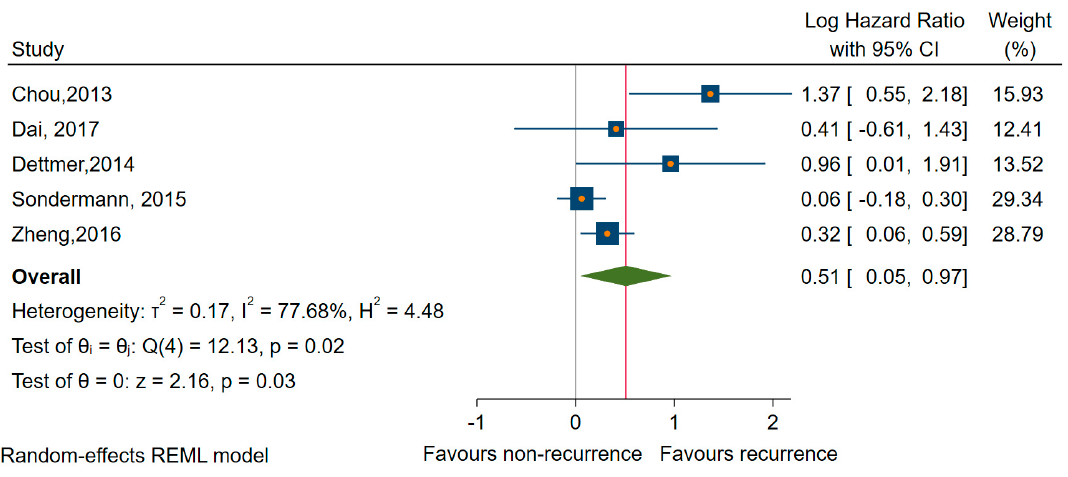
Figure 4. Forest plot of the association between the upregulates miRNAs and recurrence.